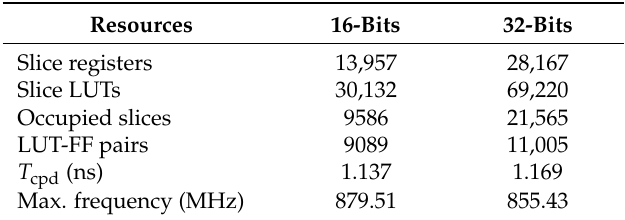
Table 2. Comparison of FPGA resource consumption for a 32-element differential form polyphased